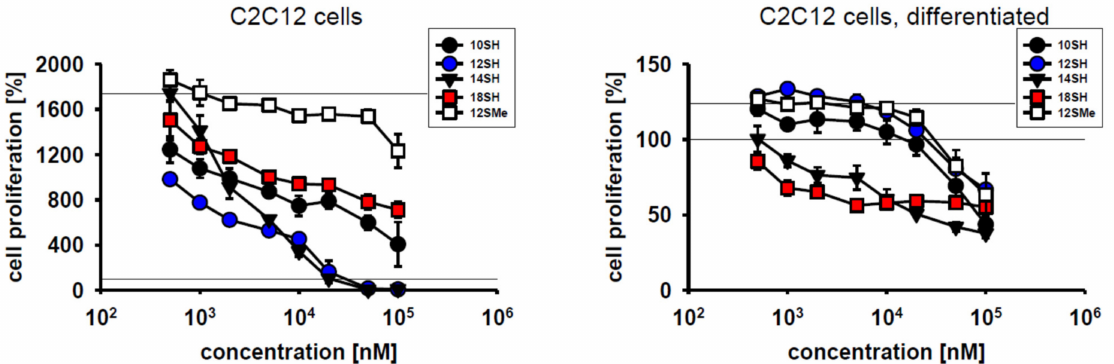
Figure 2. Cytotoxic effect of chain-transfer agents in naïve vs. differentiated C2C12 cells. Compound designations are used as in Table 1. The employed differentiation protocol involving serum withdrawal of a confluent culture led to a significant reduction of proliferation from ~1700% to ~125% as assessed by MTT